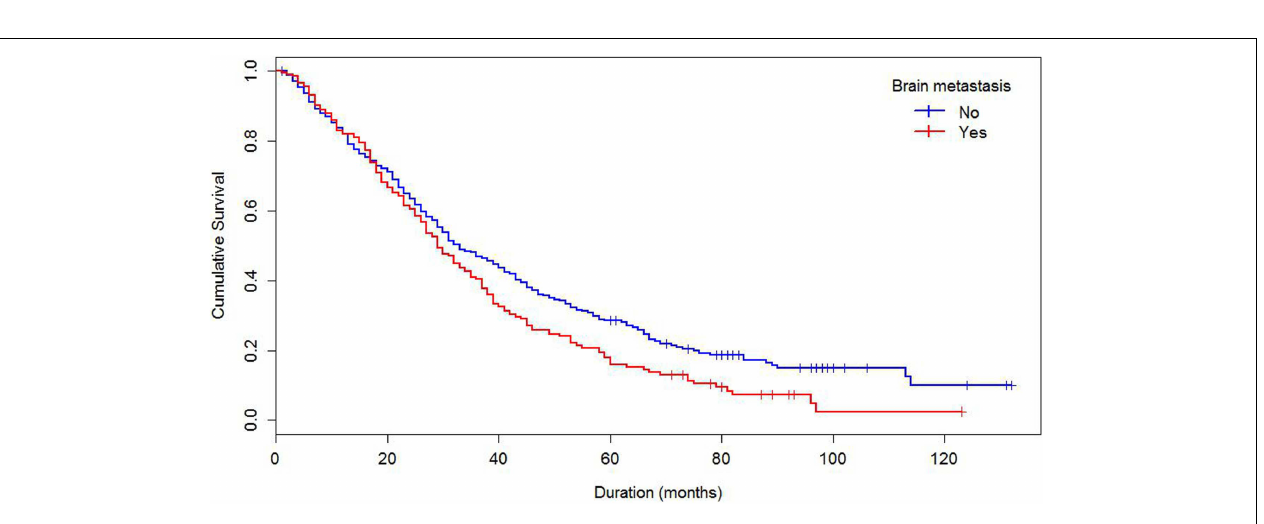
FIGURE 2 | Kaplan–Meier’s curve of survival by brain metastasis status